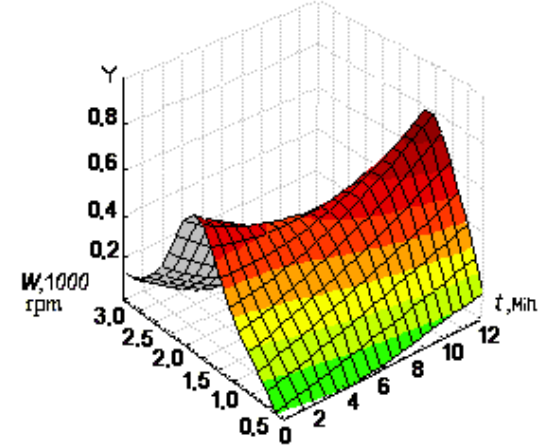
Figure 1. The surfaces of the response of function Y = 1 − I/I blood